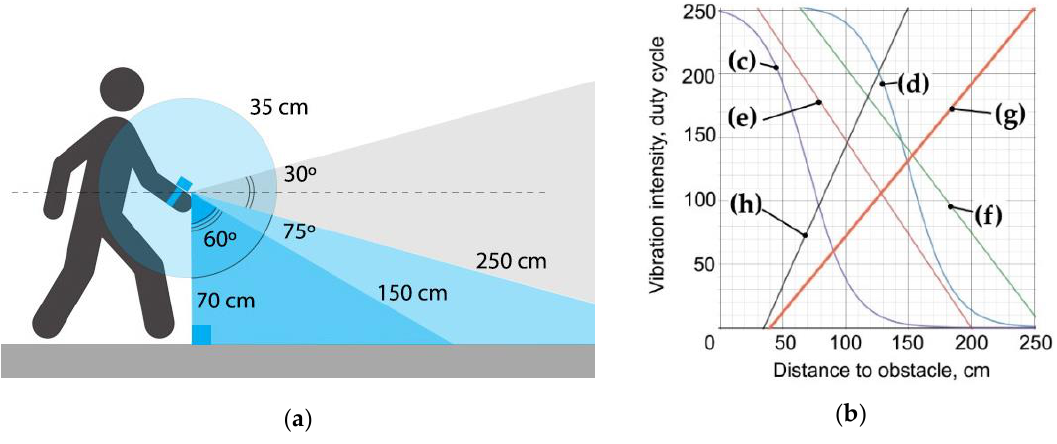
Figure 3. The ultrasonic sensor operating principles: ( a ) The principal distances (not to scale); ( b ) Calibration of the optimal duty cycle equation for the distance range of 35 cm to 150 cm, where ( c ) M DC = 127 + 127 · tanh ( − (D − 70) / 35); ( d ) M DC = 127 + 127 · tanh (-(D - 150) / 35); ( e ) M DC = 296